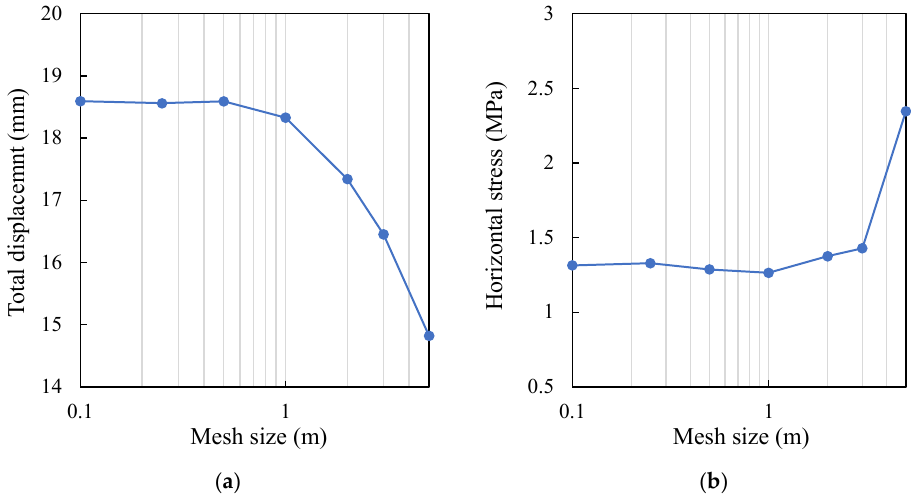
Figure A14. Variation of ( a ) total displacement at Point A after extracting the overlying stope and ( b ) horizontal stress at Point B after excavating the underlying stope as functions of the mesh size.